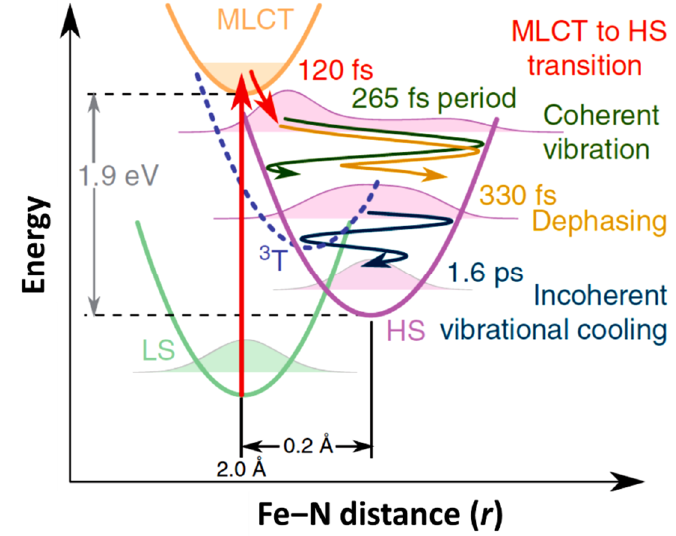
Figure 2. The schematic representation of structural dynamics of [Fe II (bpy) 3 ] 2+ in solution during the light induced spin state conversion with respect to the Fe-N distance reaction coordinate. The decay of the metal-ligand charge transfer (MLCT) state occurs with 120 fs with energy dissipation. The system then undergoes a coherent vibronic decay (at 265 fs) followed by a damping with a time constant of 330 fs. The vibrational cooling occurs within 1.6 ps [67].